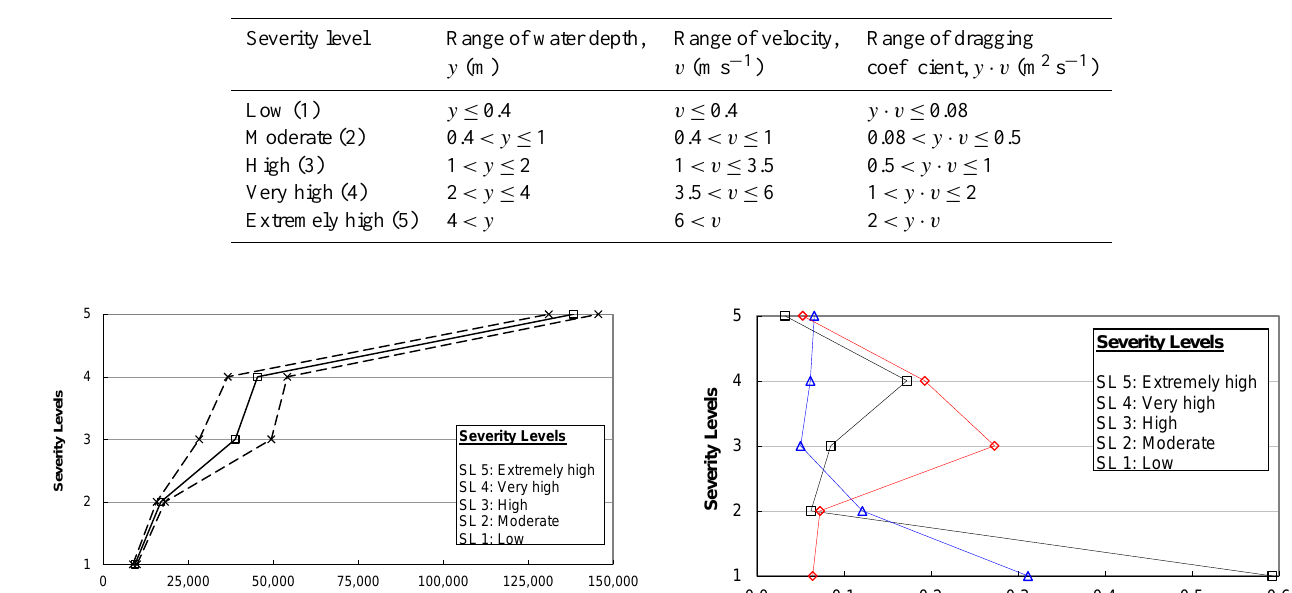
Table 10. Flood severity levels.